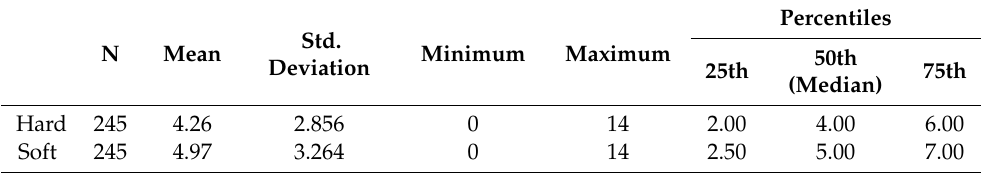
Table 16. Descriptive statistics of hard and soft